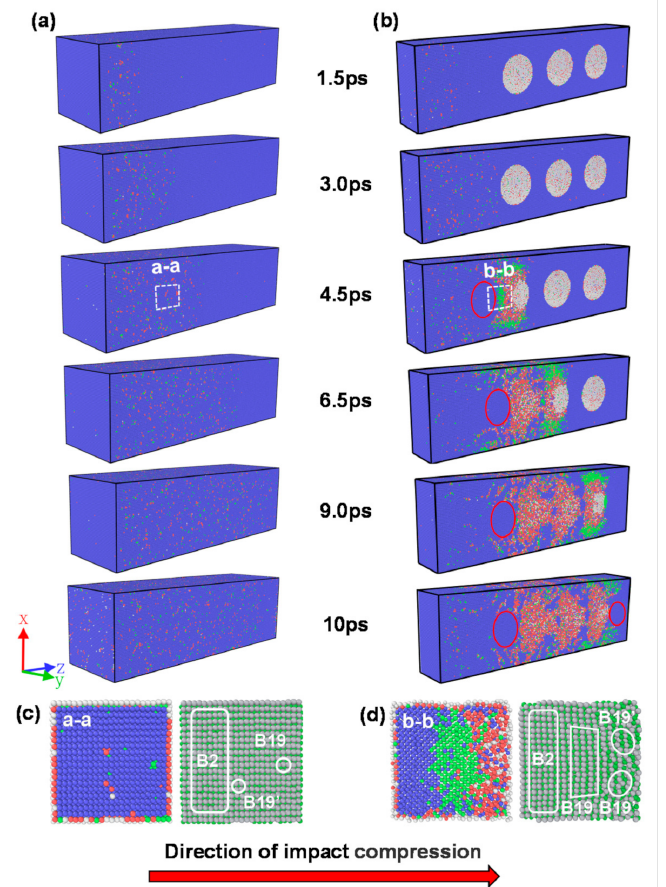
Figure 3. Atomic structure characteristics of non-porous samples and porous samples during impact compression: ( a ) non-porous samples; ( b ) porous sample profile (blue, red, green, and white atoms represent B2 phase, B19’ phase, B19 phase, and others, respectively); ( c ) cross-sectional view of the white dashed box a-a on the porous sample at 4.5 ps in Figure 3a (the left side is the structure diagram of PTM analysis, and the right side is the original structure diagram); ( d ) cross-sectional view of the white dashed box b-b on the non-porous sample at 4.5 ps in Figure 3b (the left side is the structure diagram of PTM analysis, and the right side is the original structure